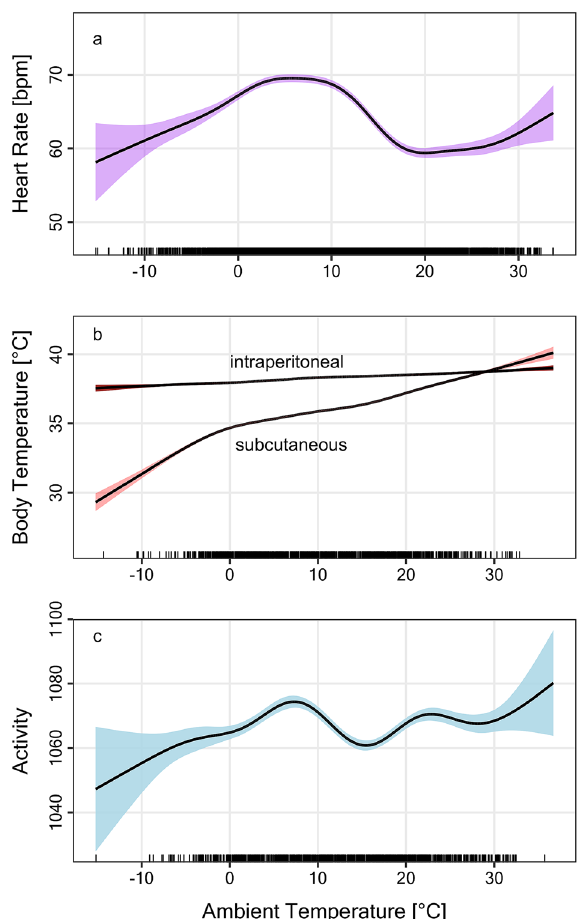
Figure 3. Effects of ambient temperature (T a ) on ( a ) heart rate, ( b ) body temperature and ( c ) activity in wild boar females. Predictions from mixed models (GAMMs) that adjusted for individual levels of the ten females. Coloured areas around the lines are 95% confidence intervals. HR and activity peaked at ~ + 8 °C ( a , c ). As T a decreased both intraperitoneal and subcutaneous T b were lowered, but this decline was much more pronounced in subcutaneous T b